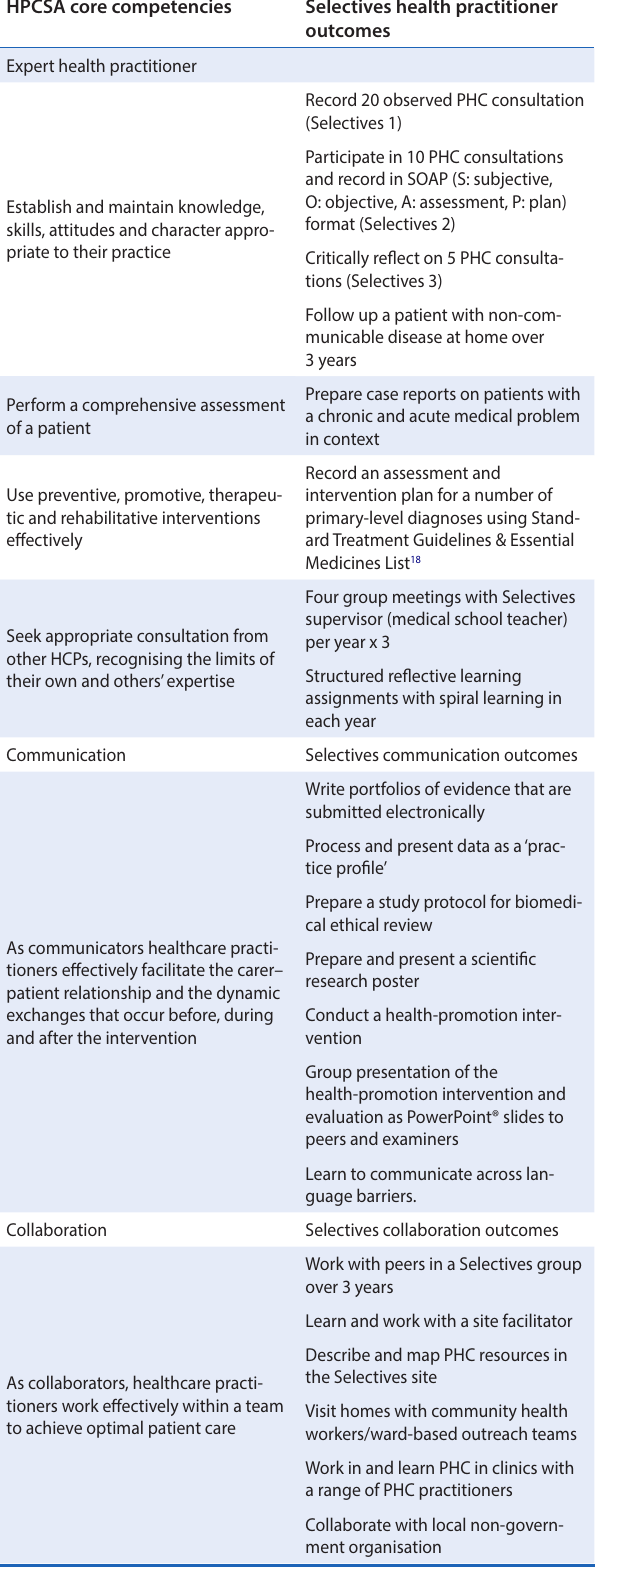
Table 1: Selectives Programme outcomes aligned to HPCSA graduate ‘core competencies’ HPCSA core